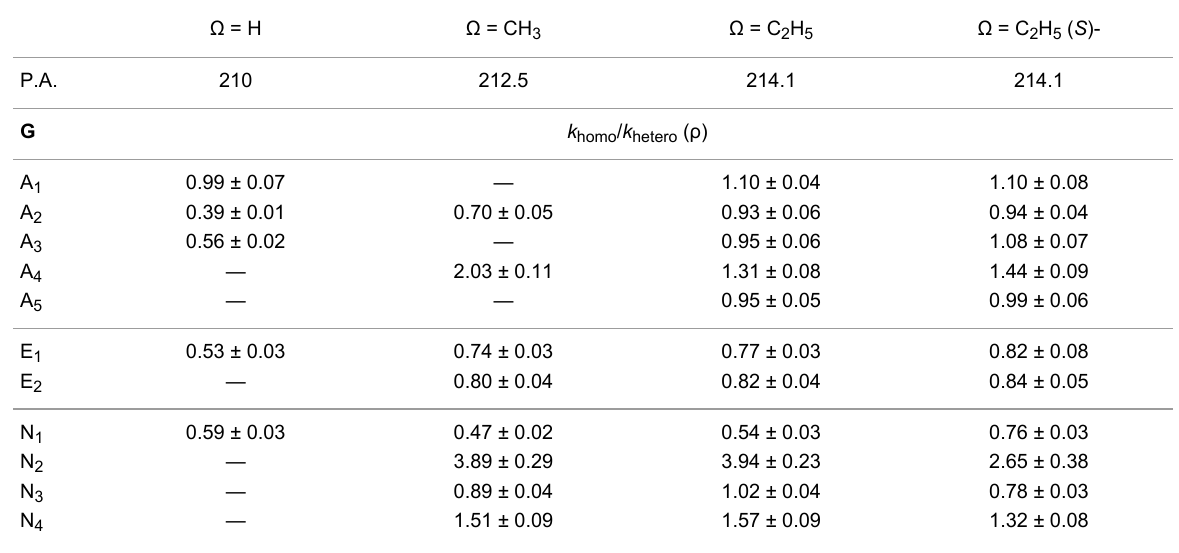
Table 5: k homo / k hetero measured for reactions of [ C H ∙ H ∙ G] + /[ C D ∙ H ∙ G] + complexes with B